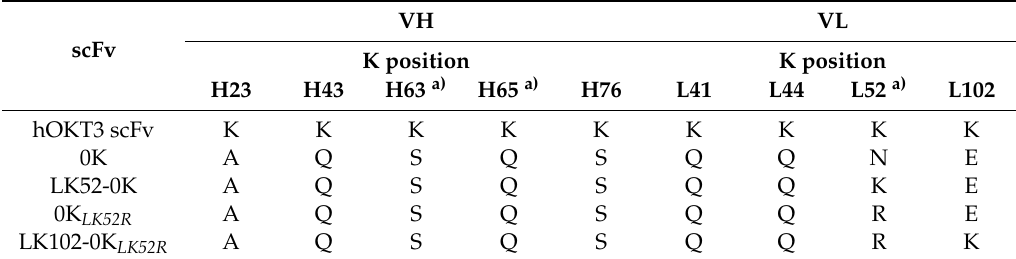
Table 3. Mutations of lysine residues in the hOKT3